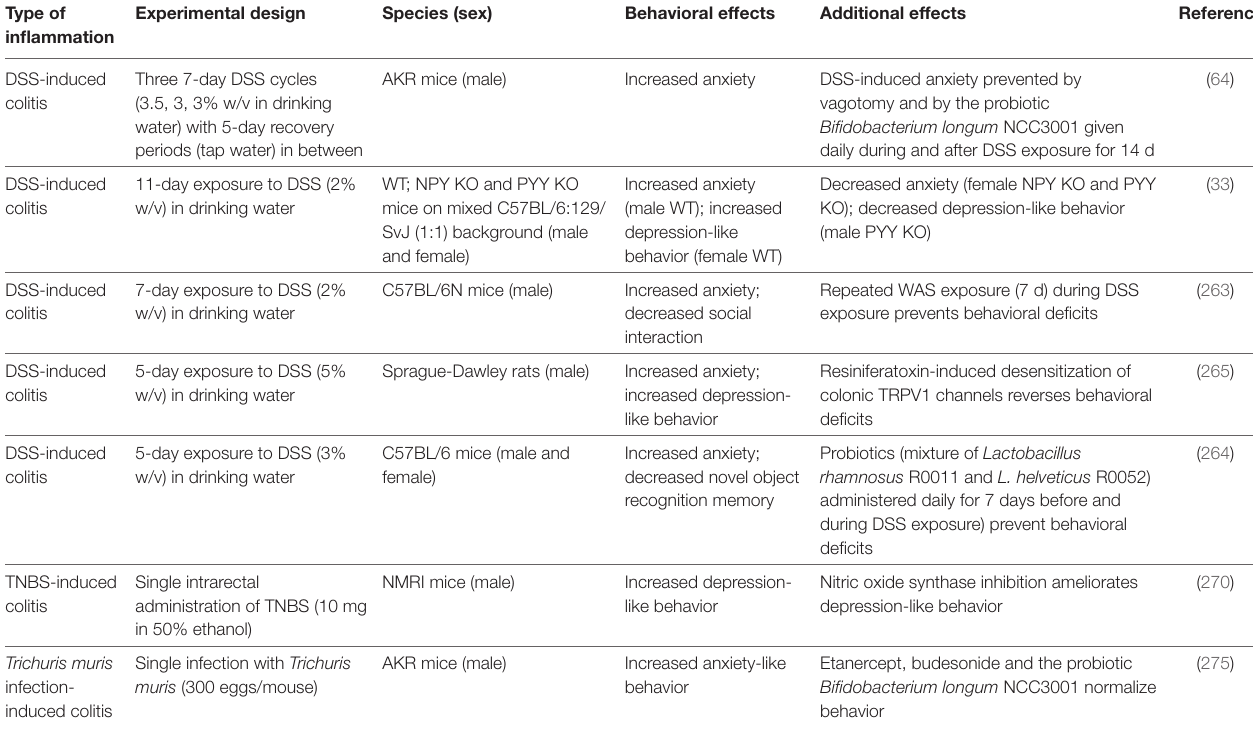
TABLe 2 | Effects of gastrointestinal inflammation on emotional-affective and cognitive